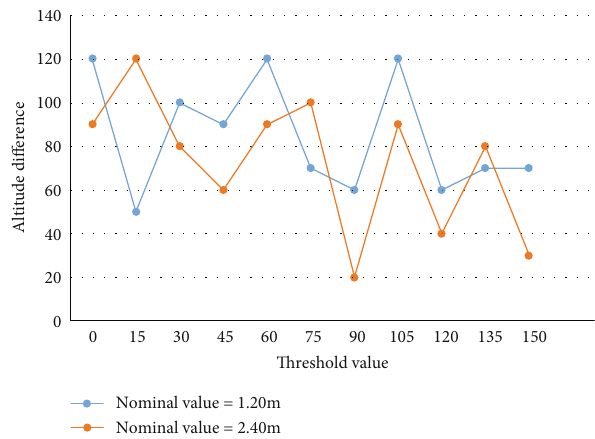
Figure 8: Relationship curves of error thresholds of group operators with di ff erent nominal